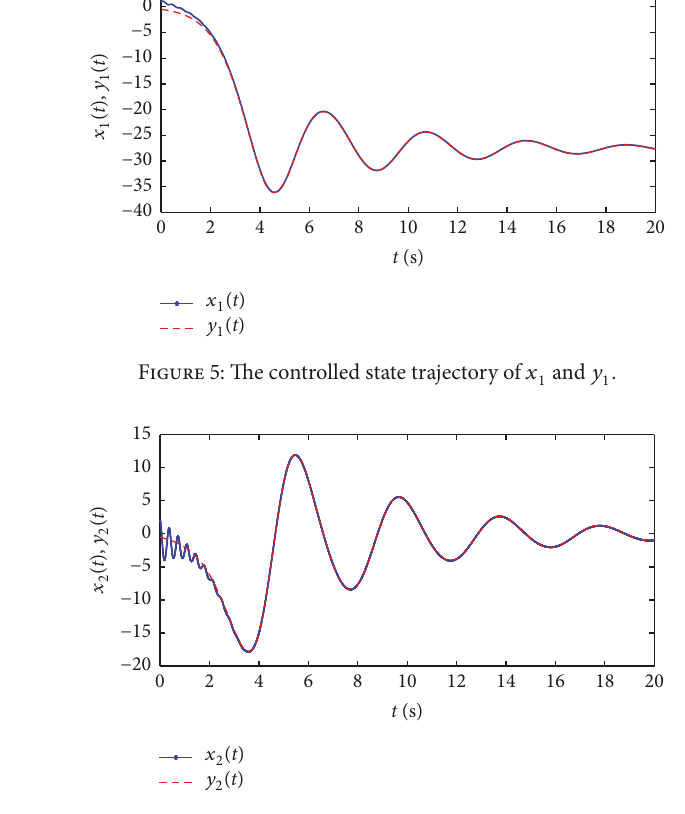
Figure 6: The controlled state trajectory of 𝑥 2 and 𝑦 2